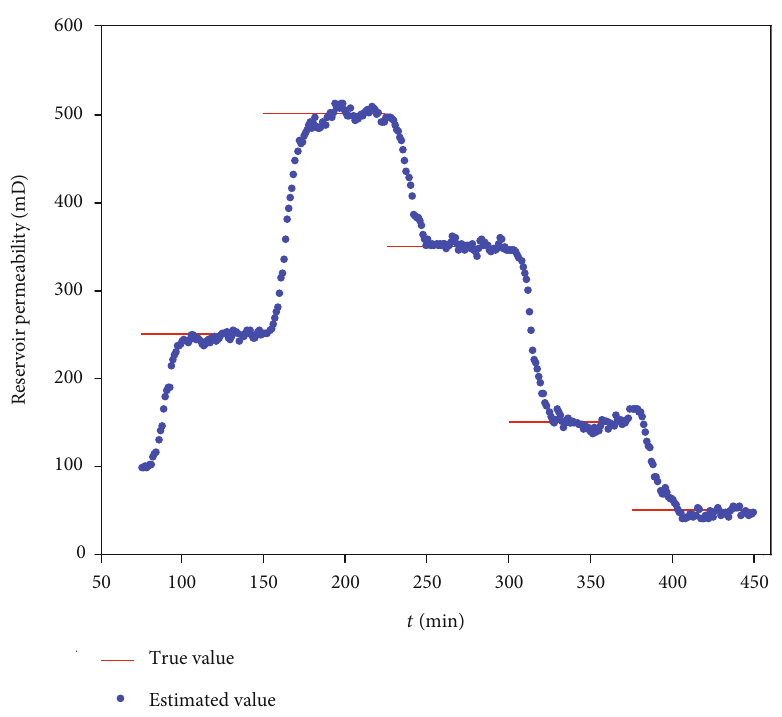
Figure 4: Liquid outlet rate variation (case 1).